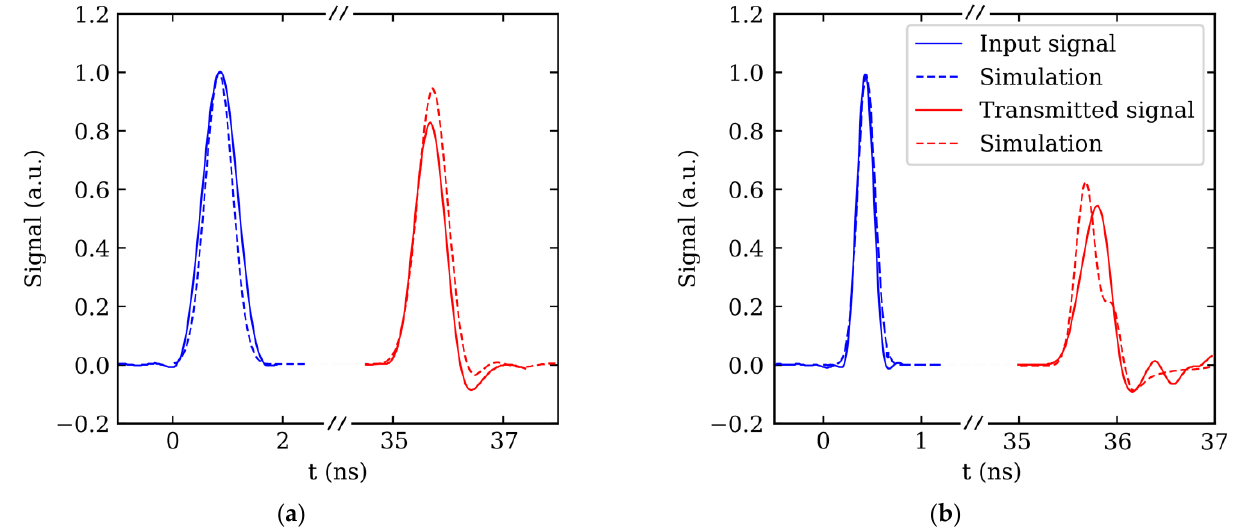
Figure 11. Experimentally measured input and transmitted signals with unipolar EMP with duration of 600 ps ( a ), and 200 ps ( b ).